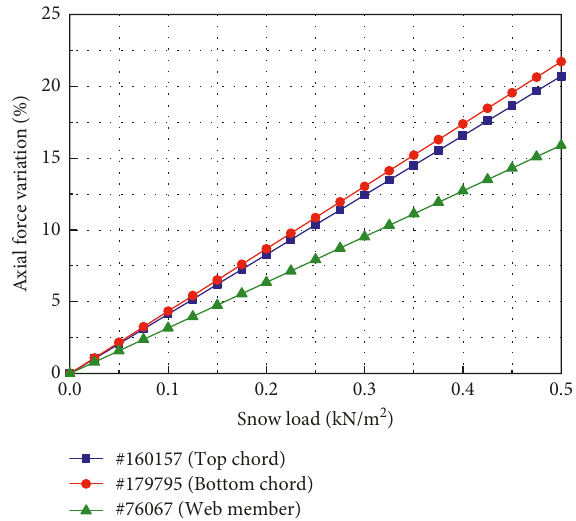
Figure 20: Axial force variation under uniformly distributed snow